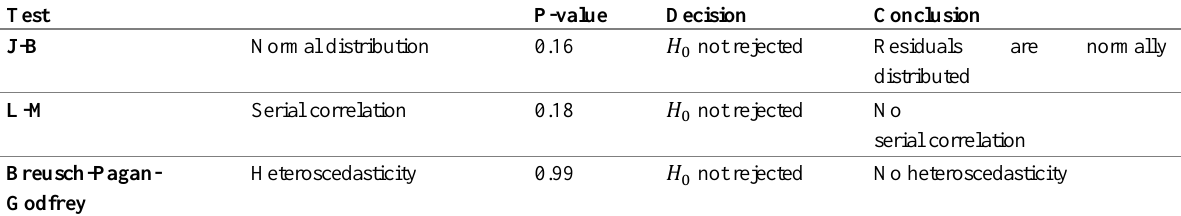
Table 9: Model Diagnostic Results